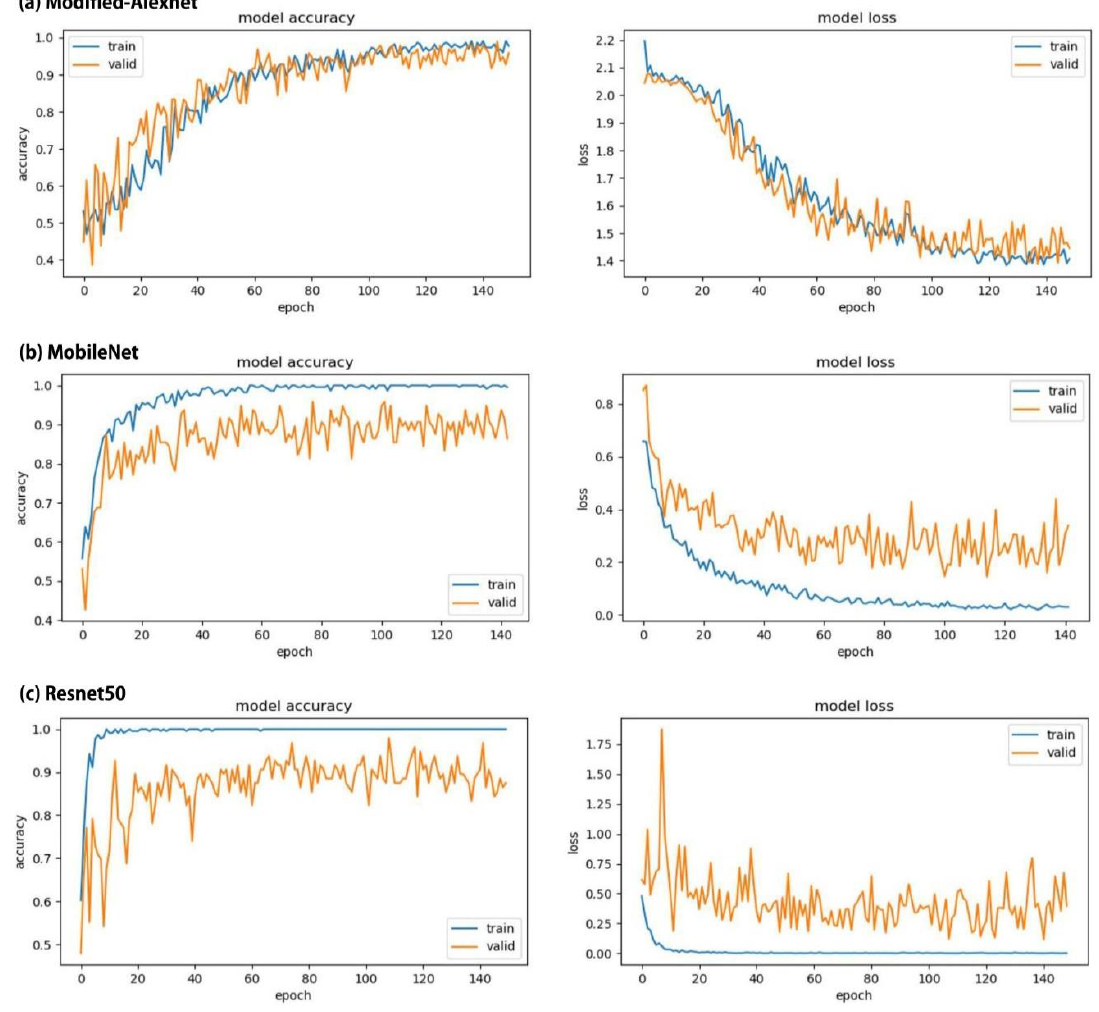
Figure 7. Graphs of the performance of the accuracy and the loss function of each model. ( a ) Modified-Alexnet, ( b ) MobileNet, and ( c ) Resnet50 .